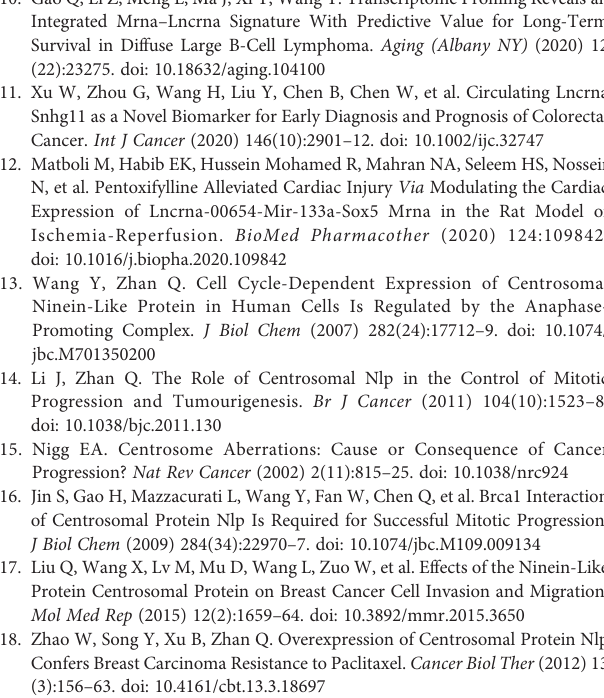
Supplementary Table 1 | Batch Cox analysis of lncRNAs with prognosis outcome. Supplementary Table 2 | Co-expression target genes of LINC00654 Supplementary Table 3 | TOP 10 items of NINL GO enrichment